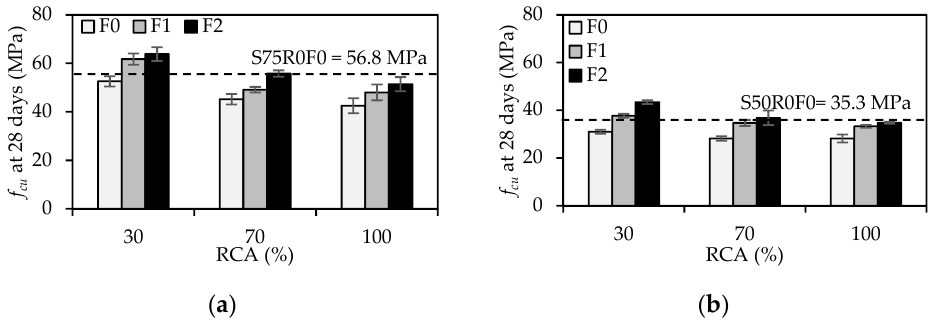
Figure 7. Cubic compressive strength of 28-day alkali-activated slag-fly ash blended concrete mix- tures: ( a ) 3:1 slag:fly ash; ( b ) 1:1 slag:fly ash.